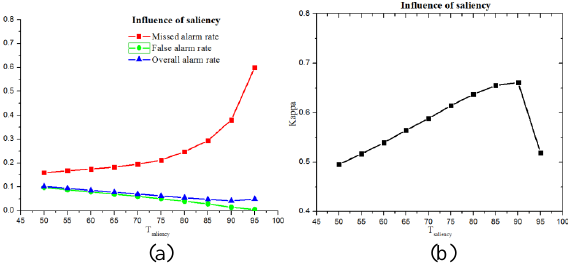
Figure 4. The influence of saliency on the experimental dataset. Influence of saliency (a) on FA, MA and OE; (b) on kappa